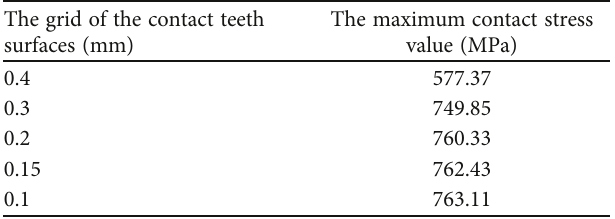
maximum contact